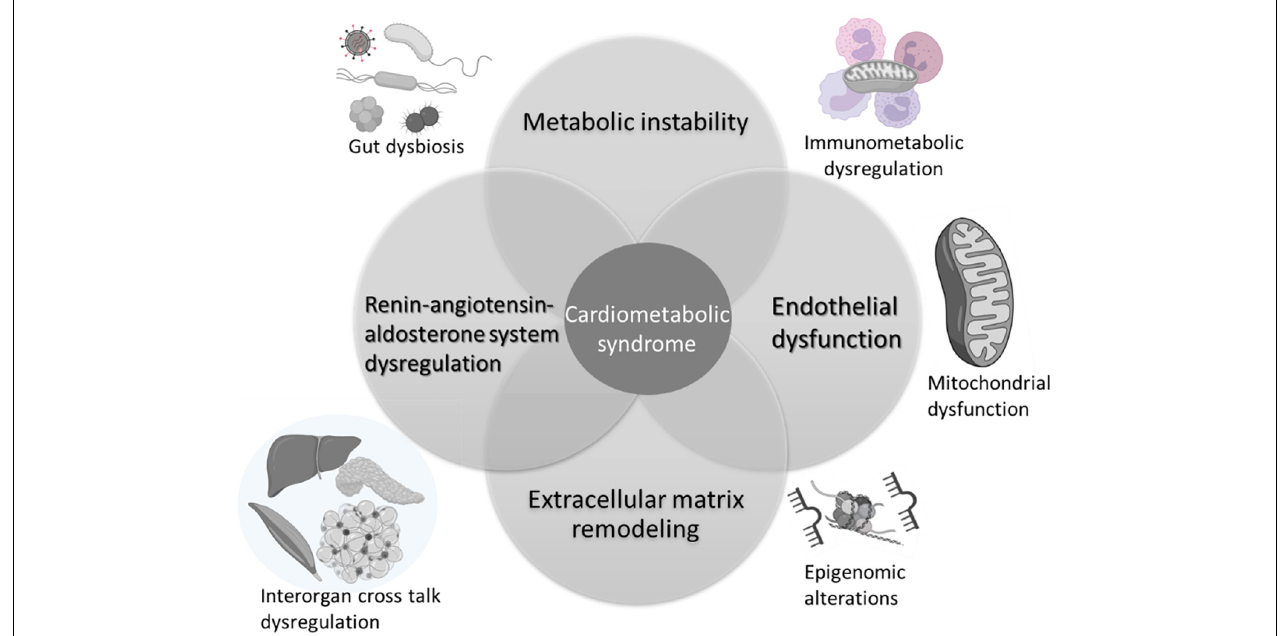
FIGURE 2 | Mechanisms implicated in alcohol interactions with risk and pathogenesis of cardiometabolic syndrome. Alcohol associated metabolic instability, alterations in endothelial function, extracellular remodeling, and dysregulation of the renin-angiotensin aldosterone system are salient mechanisms that contribute to increased risk for CMS. Alcohol alters the gut microbiome, impacting on gut mucosal immunity and barrier function. The chronic immune activation associated with gut leak results in immune activation, exhaustion, and senescence, underlying immunometabolic dysregulation. Across tissues, alcohol produces alterations in cellular energy metabolism disrupting mitochondrial function and homeostatic responses. Several of these mechanisms are regulated by epigenomic alterations reflected by changes in microRNA profiles, histone methyltransferases and deacetylase expression, and activity. Alcohol-induced multi-organ alterations may result from inter-organ cross talk. Alcohol-induced tissue injury in one organ (i.e., adipose tissue) can result in release of mediators (i.e., adipokines, cytokines, microvesicles, etc.) that target distant organs amplifying alcohol’s deleterious effects. Created with